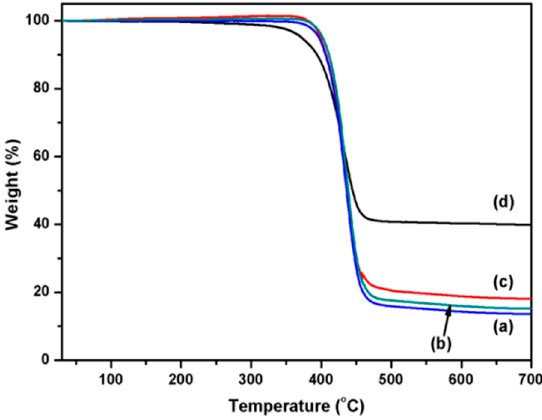
Figure 9. Thermogravimetry (TG) curves of ( a ) PET fabrics; ( b ) PDA/PET fabrics; ( c ) Ag/PDA/PET fabrics; and ( d ) Cu/Ag/PDA/PET fabrics.